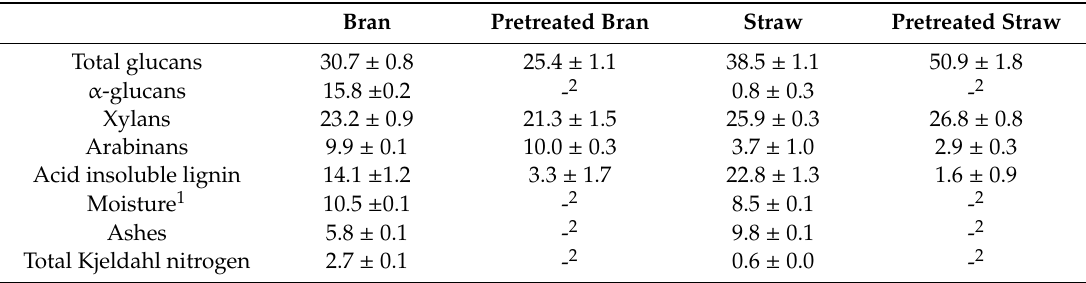
Table 1. Characterization of the lignocellulosic materials before and after the alkali pretreatment (% w / w, dry